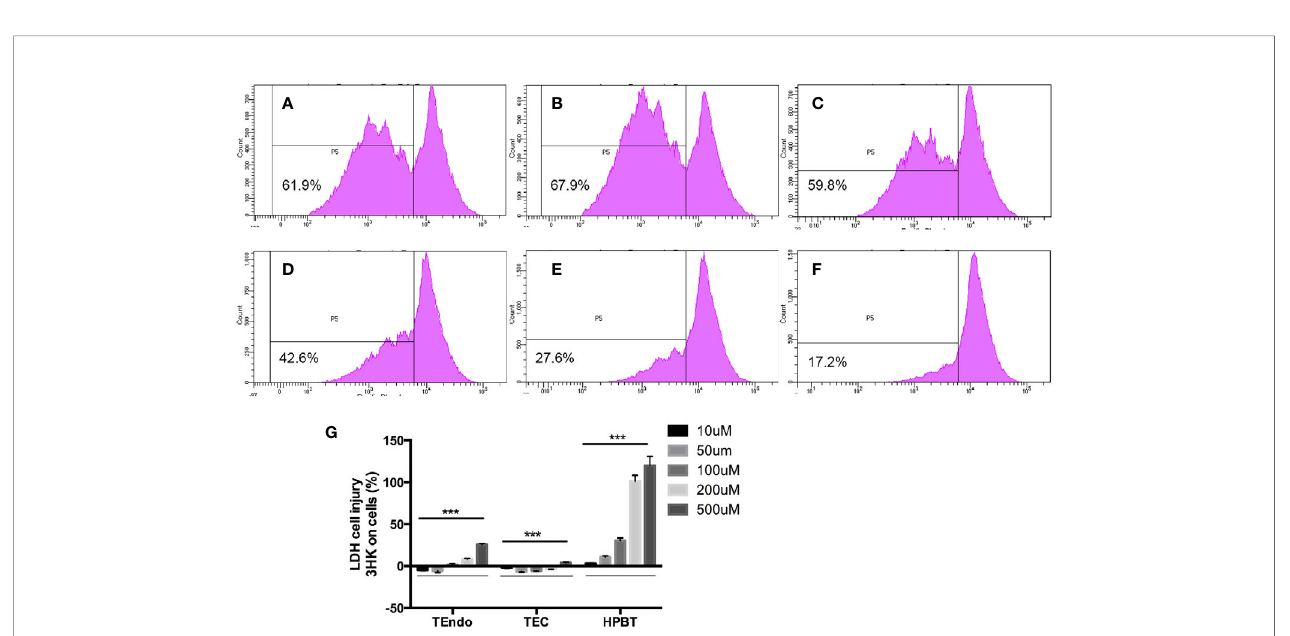
FIGURE 7 | Effects of 3HK and 3HAA on hPBT proliferation and 3HK toxicity on TEndo, TEC, and hPBT. hPBT cell proliferation in (A) normal medium, (B) cytokine cocktail; (C) cytokine cocktail plus 3HK (50 µg/ml); (D) cytokine cocktail plus 3HK (100 µg/ml); (E) cytokine cocktail plus 3HAA (10 µg/ml) and (F) cytokine cocktail plus 3HAA (20 µg/ml); the data of fl ow cytometry is representative of four independent experiments. (G) Cytotoxicity of 3HK on Endo, TEC, and hPBT. The assay is representative of four independent experiments. *** P < 0.001 versus cells without treatment; analysis is the unpaired